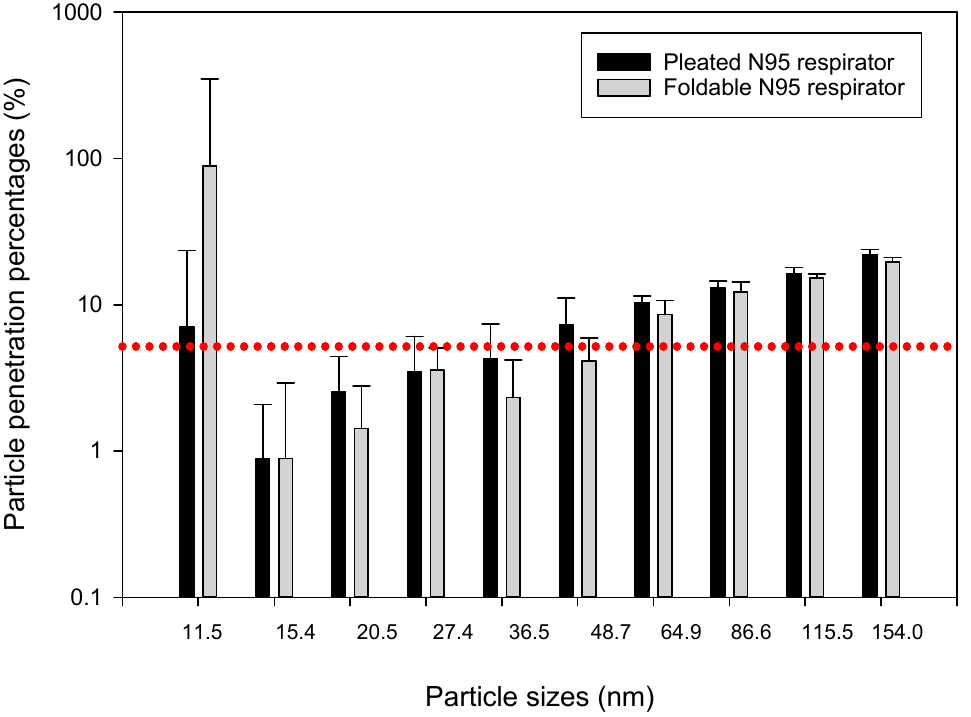
Figure 8. Penetration percentages of particles of 11.4–154.0 nm size range in isopropanol-treated N95 masks during soil moving in a large construction site. The dotted red line indicates the 5% particle penetration percentages, to be considered as the efficacy threshold for N95 respirators.